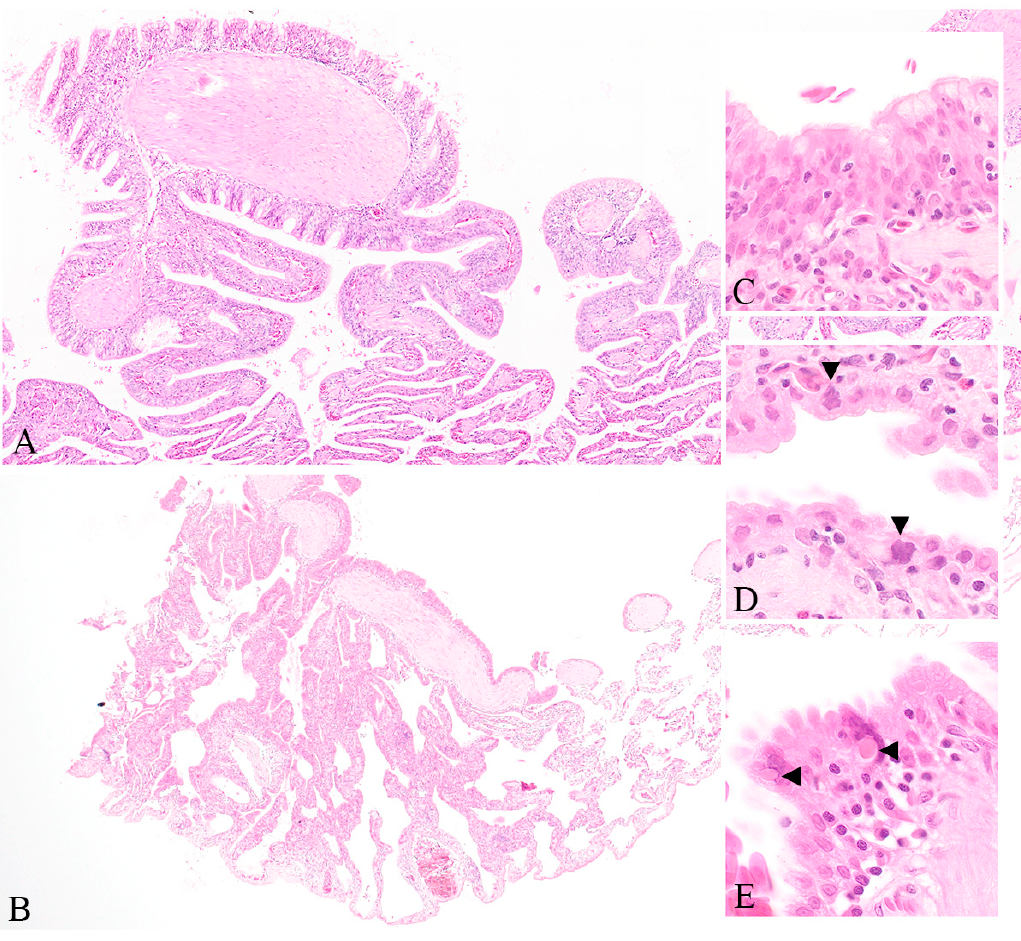
Figure 1. Photomicrographs of pulmonary lesions in central bearded dragons from the 2014 and 2020 outbreak. Thickening of the normally squamous infundibular epithelium. (Haematoxylin and eosin (HE) stain 40×) ( A ) and the segmental nature of this change observed in an affected animal from the 2020 outbreak (HE 20×) ( B ) Metaplasia of the normally squamous infundibular epithelium to pseudostratified columnar and multifocally ciliate. Normal lung appears on the right and infundibular epithelium becomes proliferative on the left (HE 1000×)( C ) and multifocal epithelial cells with large, irregularly shaped, basophilic nuclei (arrowheads, HE 1000×) ( D ) Bizarre atrial epithelial cells containing eosinophilic cytoplasmic inclusions (arrowheads, (HE 1000×) ( E )